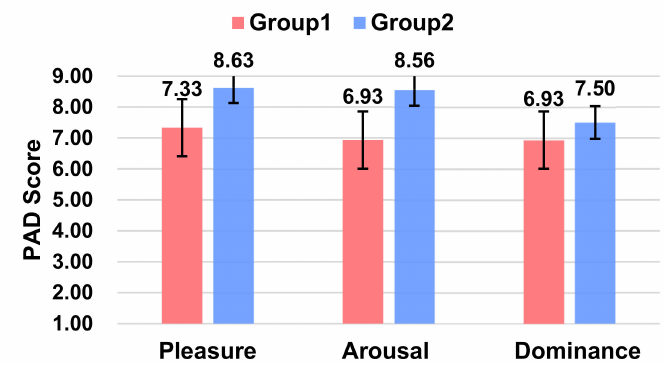
Figure 7. Ratings of Pleasure, Arousal, and Dominance between the two groups.